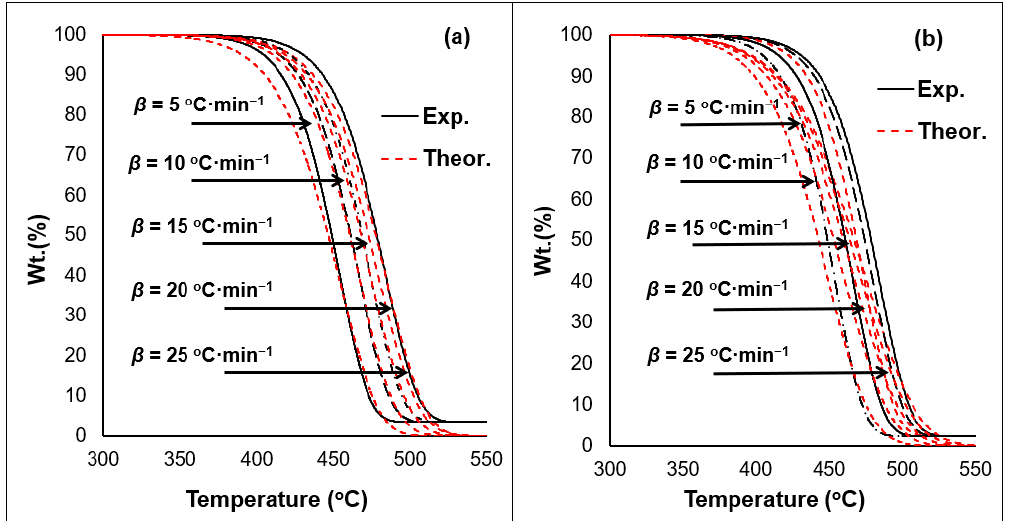
Figure 9. Experimental (Exp.) vs. theoretical (Theor.) results obtained from the analytical solution model for the ( a ) pre-exposed and ( b ) exposed 50/50 samples.